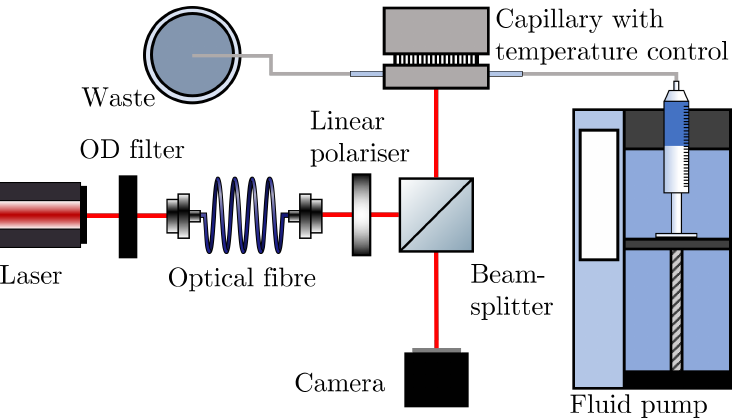
Figure 1. A schematic diagram of the backscattering interferometry apparatus used in this work. A laser (JDS Uniphase 1137P, 7 mW) is passed through an optical fibre (ThorLabs, S405- XP) and linear polariser (ThorLabs, LPVISE100-A) to obtain an single spatial mode with a linear polarisation state. This light is incident on a circular cross-section glass capillary (Drummond, ID 0.556 mm, OD 0.800 mm, and ID 0.343 mm, OD 0.864 mm) of some